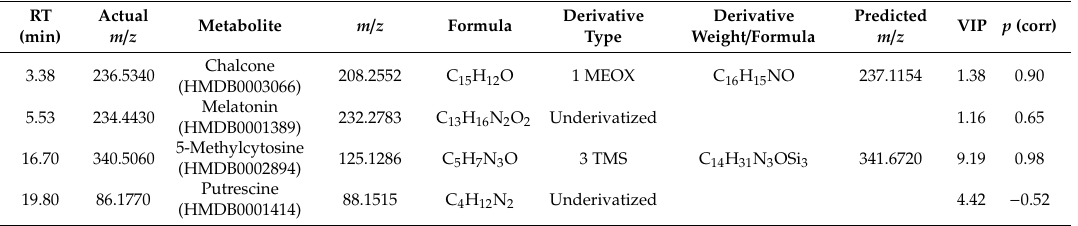
Figure 5. The e ff ect of BA-12 on angiogenesis in HUVECs. ( A ) Inhibition rate of cell viability of HUVECs by MTT assays (cells treated with BA-12 at doses of 0.25–160 µ M) for 24, 48, and 72 h. ( B ) Inhibition rate of cell viability of HUVECs for MTT assays for 24 h. ( C ) Cellular VEGFR levels and grayscale analysis. ( D , E ) Results for wound scratch assay and tube formation assay after 24 h under the microscope (100×). Con, control group treated with PBS; Dis, dissolvent group treated with dissolvent containing 0.5% DMSO; Pos, positive control group treated with dovitinib (2.5 μ M); BA-12, groups treated with BA-12 at doses of 2.5 μ M. Representative fields are shown. ANOVA with a post hoc test was applied for the significance of the differences; * p < 0.05, ** p < 0.01 compared with the dissolvent group. Experiments were executed three times. Results are displayed as means ± SD. Table 2. Di ff erential identified metabolites for discrimination among control and BA-12 groups based on GC–MS metabolomics. RT—retention time; VIP—variable importance for projection; MEOX—methoxime;